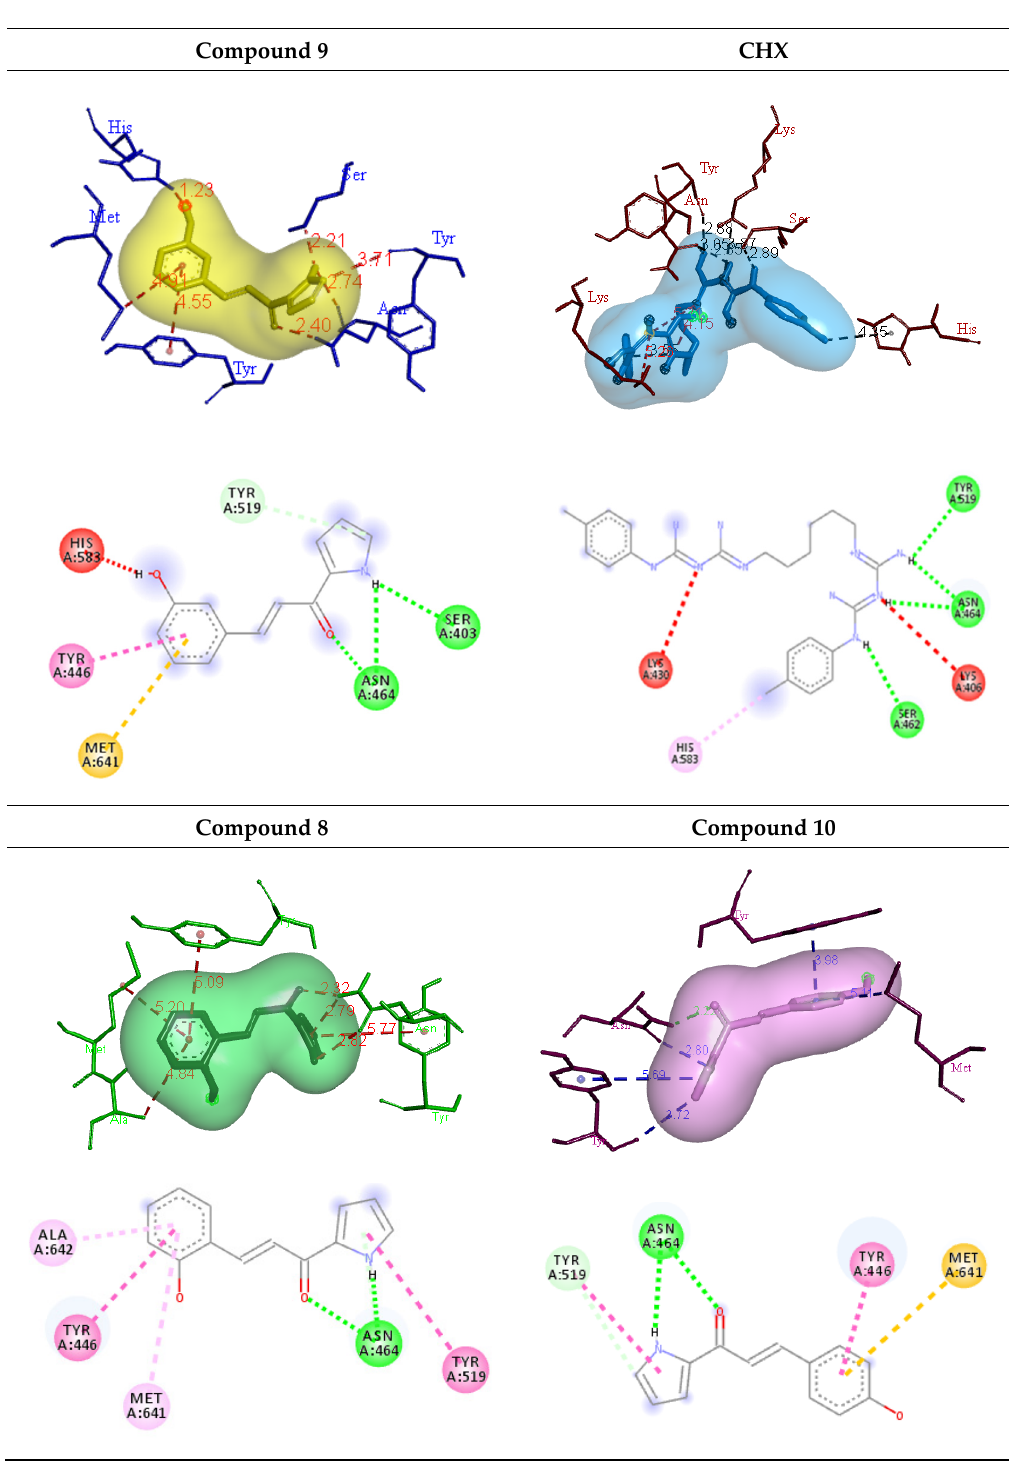
Figure 3. 3D and 2D diagrams of the binding interaction of hydroxylated compounds 8 , 9 , and 10 (green line: H bond; light green line; carbon H bond/ π -donor H bond; red line: donor-donor; yellow line: π -sulphur; pink line: π - π stacked/ π - π T-shaped; light pink line: π -alkyl) and CHX (green line: H bond; red line: positive-positive; light purple line: π -alkyl) with the amino acid residues on the active site of the PBP2a receptor.